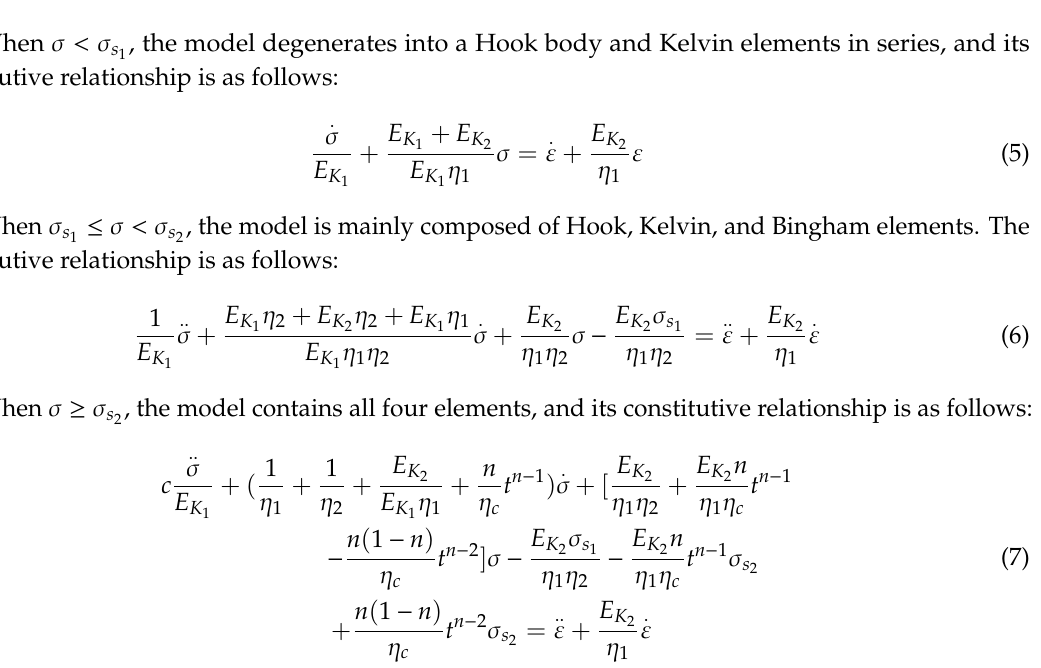
Figure 9. Effect of parameter n on the creep behaviours of NVPB. Figure 9. E ff ect of parameter n on the creep behaviours of